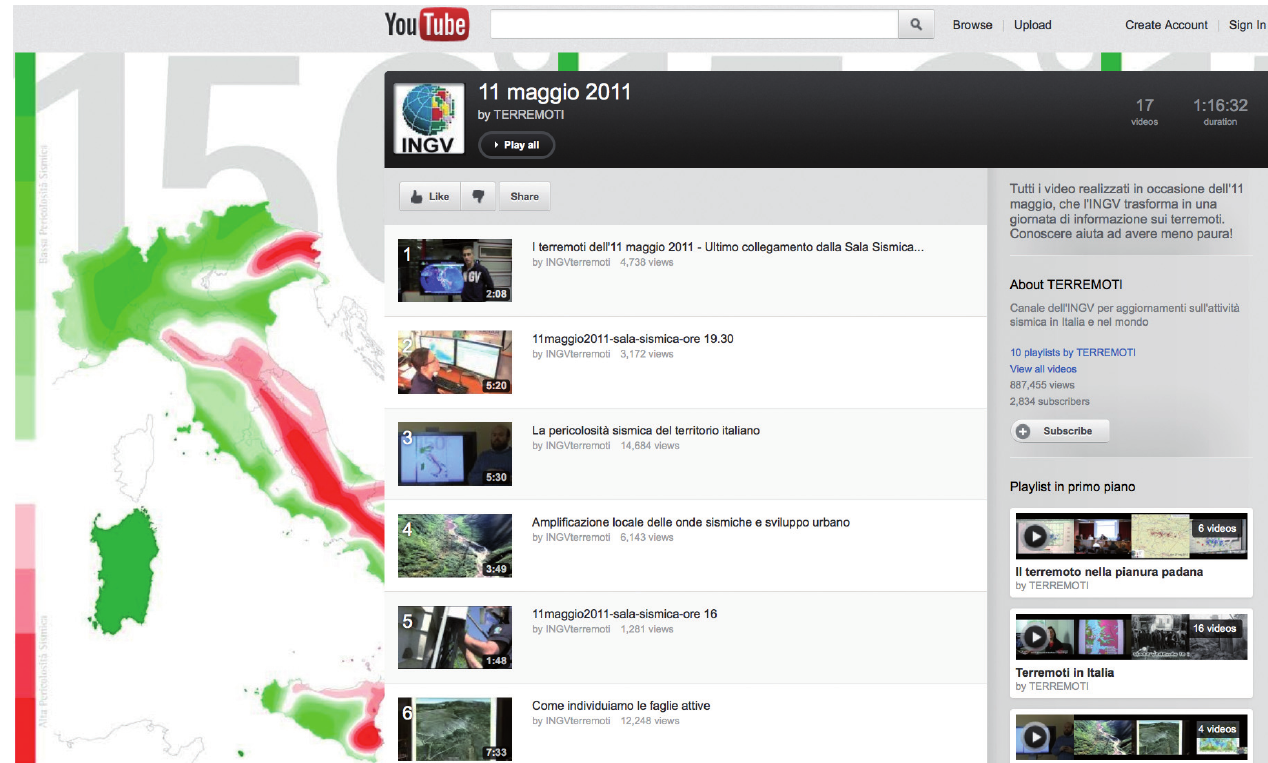
Figure 5. The 15 videos included in the ‘playlist’ named ‘11 maggio 2011’. This playlist include all of the videos recorded for May 11,